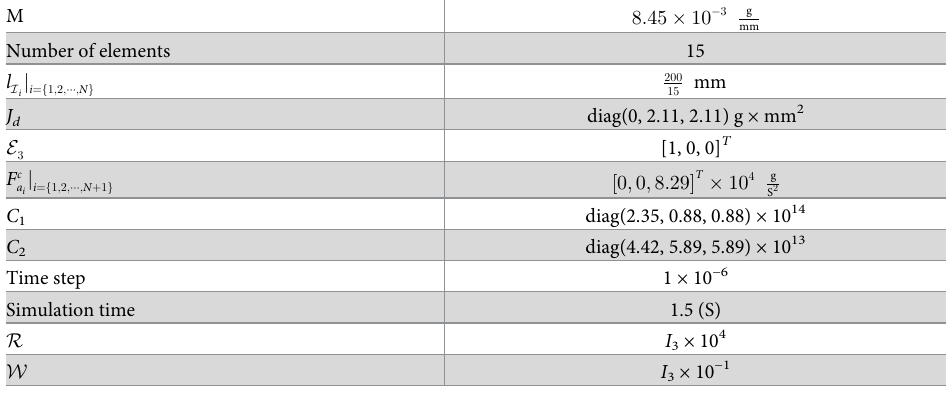
Table 3. Simulation parameters in Eqs (10)–(16)and (21) for in-plane experiment of flexible cylindrical rod